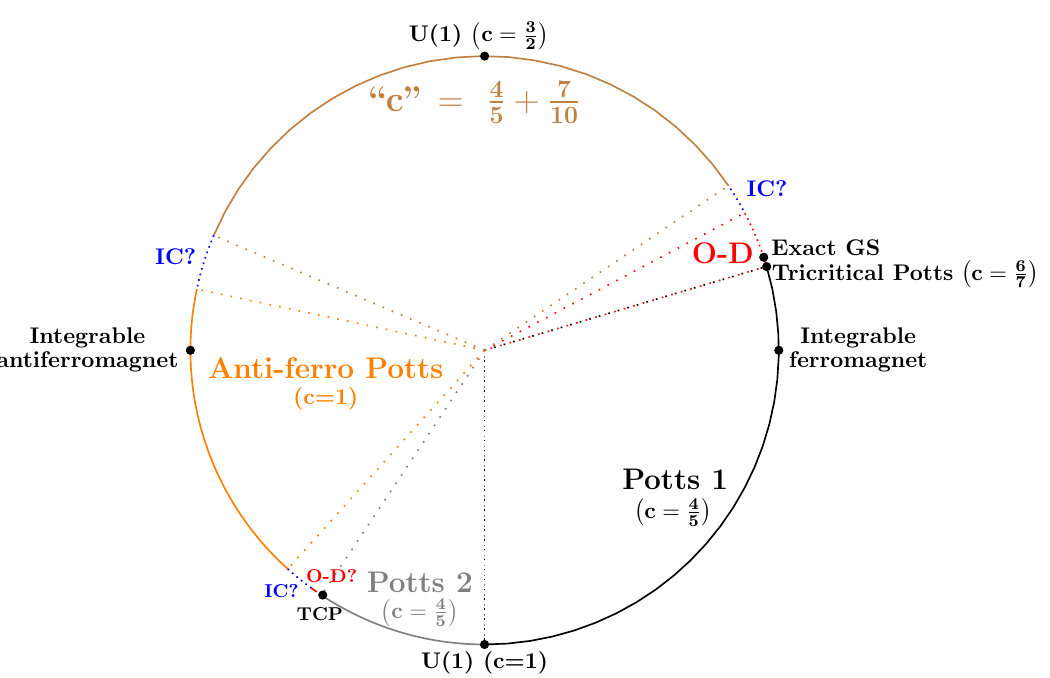
Figure 1: The phase diagram of Hamiltonian (8), including four large critical regions, one or two gapped phases with order-disorder (O-D) coexistence, and possible gap- less incommensurate (IC)